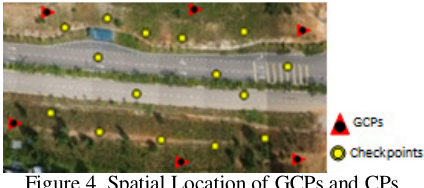
Figure 4. Spatial Location of GCPs and CPs